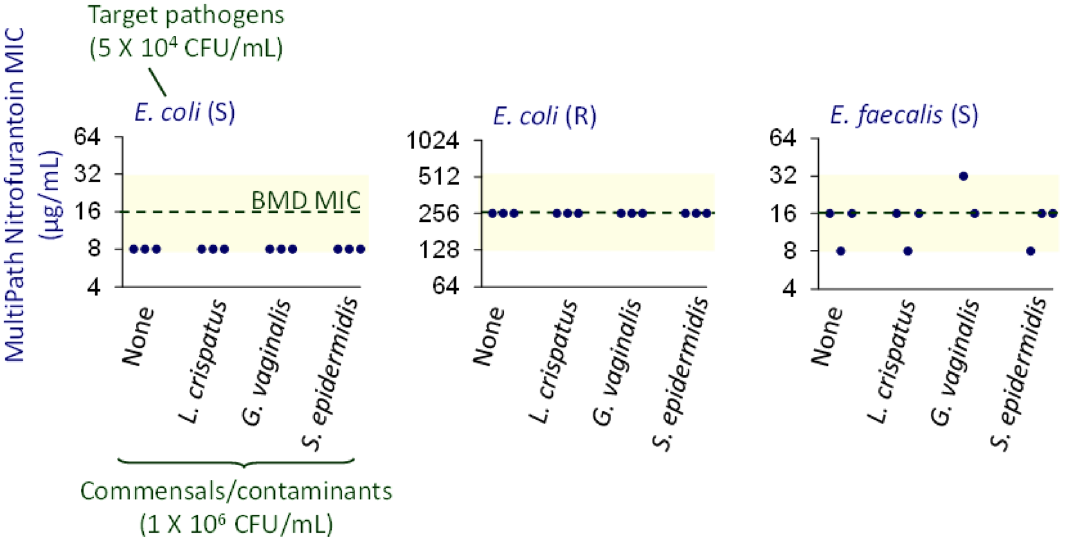
Figure 7. MultiPath AST accuracy in the presence of commensal and contaminating bacteria. Nitrofurantoin susceptibility results (MIC) for 3 target uropathogens either alone or with a urine commensal or contaminating bacteria as shown. Target strains were E. coli ARLG 1050 (S), E. coli BI 703 (R) and E. faecalis CDC 580 (S). Samples were contrived in SEC-processed urine. The dashed line denotes the MIC result for the target pathogen found using the BMD reference method. The yellow shaded area shows the limits of essential agreement with the BMD method. CLSI breakpoints for these pathogens with nitrofurantoin are S ≤ 32, I = 64, and R ≥ 128 µg/ mL.